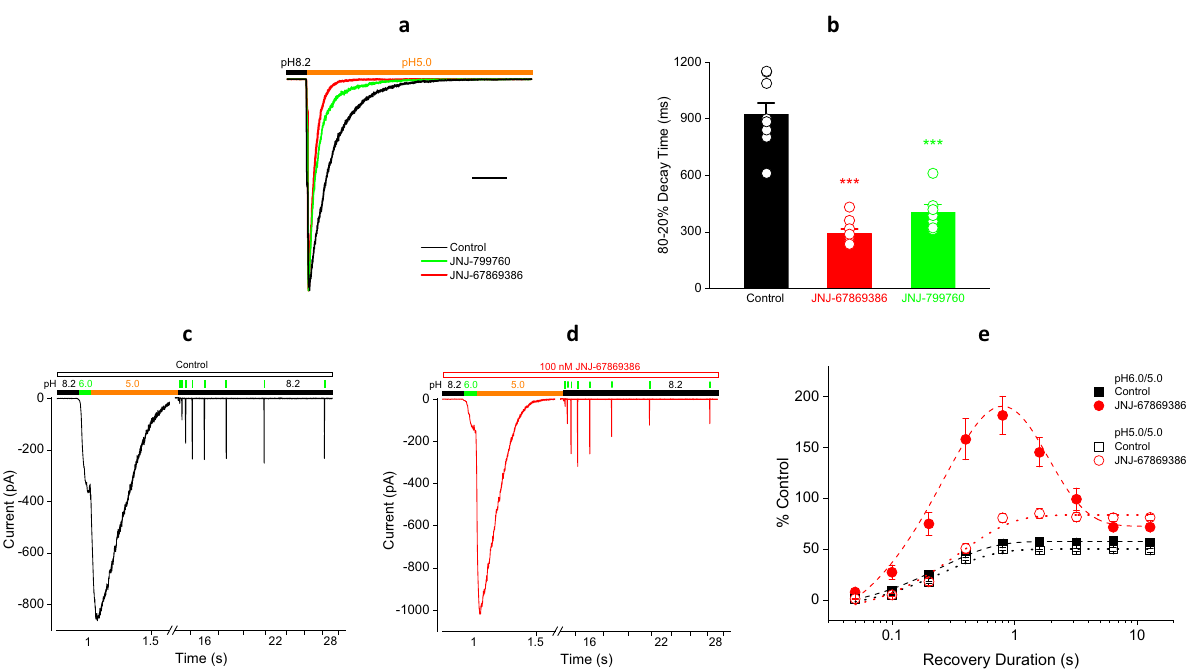
Fig. 4 Effect of JNJ-67869386 and JNJ-799760 on the kinetics of open-state desensitization. a Current traces (scaled to the control peak) showing pH 5.0-induced desensitization in control, JNJ-67869386 and JNJ-799760 (both 100 nM). Scale bar: 1 s. b Summary of 80 – 20% current decay time for all experiments like ( a ). Data for JNJ-67869386 ( n = 10) and JNJ-799760 ( n = 7) are both statistically different from control ( n = 9) ( p < 0.001; one-way ANOVA). Data for individual cells are shown in open circles. c and d Current traces showing the time course of recovery from pH 5.0-induced desensitization without ( c ) and with ( d ) 100 nM JNJ-67869386. A 14 s pH 5.0 pulse is immediately preceded by a brief pH 6.0 test pulse and followed by